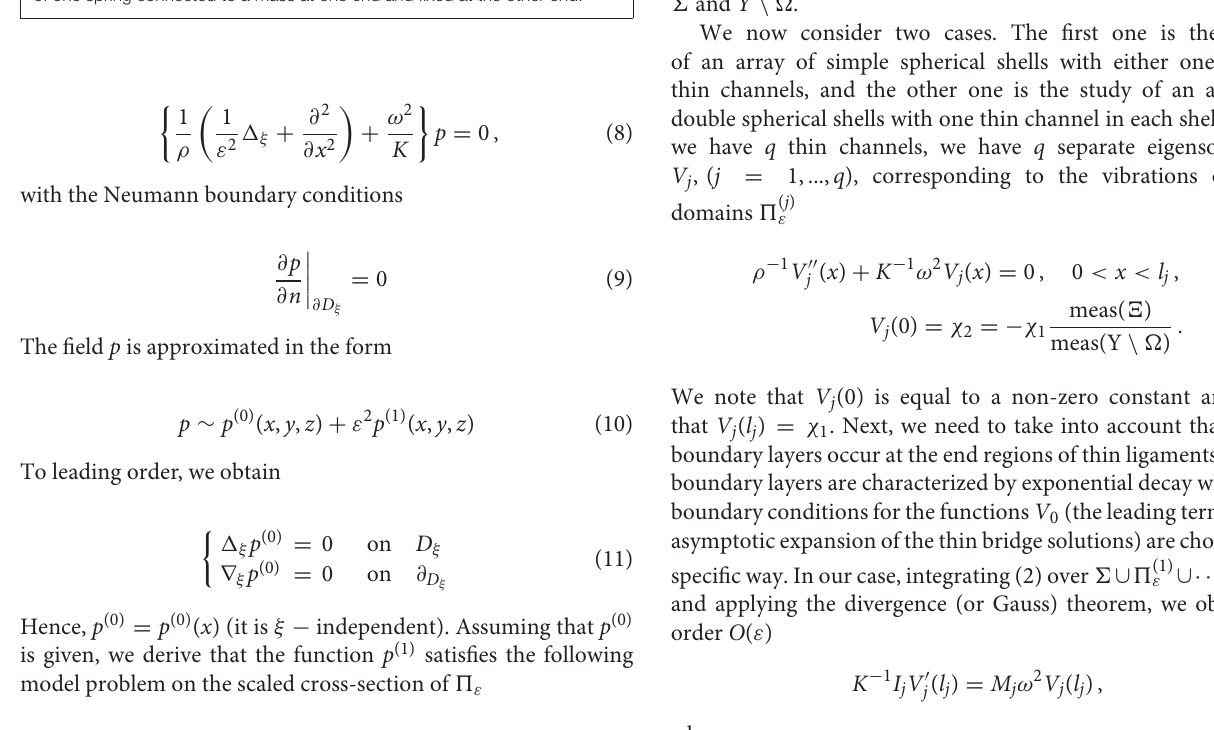
FIGURE 3 | Geometry of the inclusions and the Helmholtz oscillator consisting of one spring connected to a mass at one end and fixed at the other